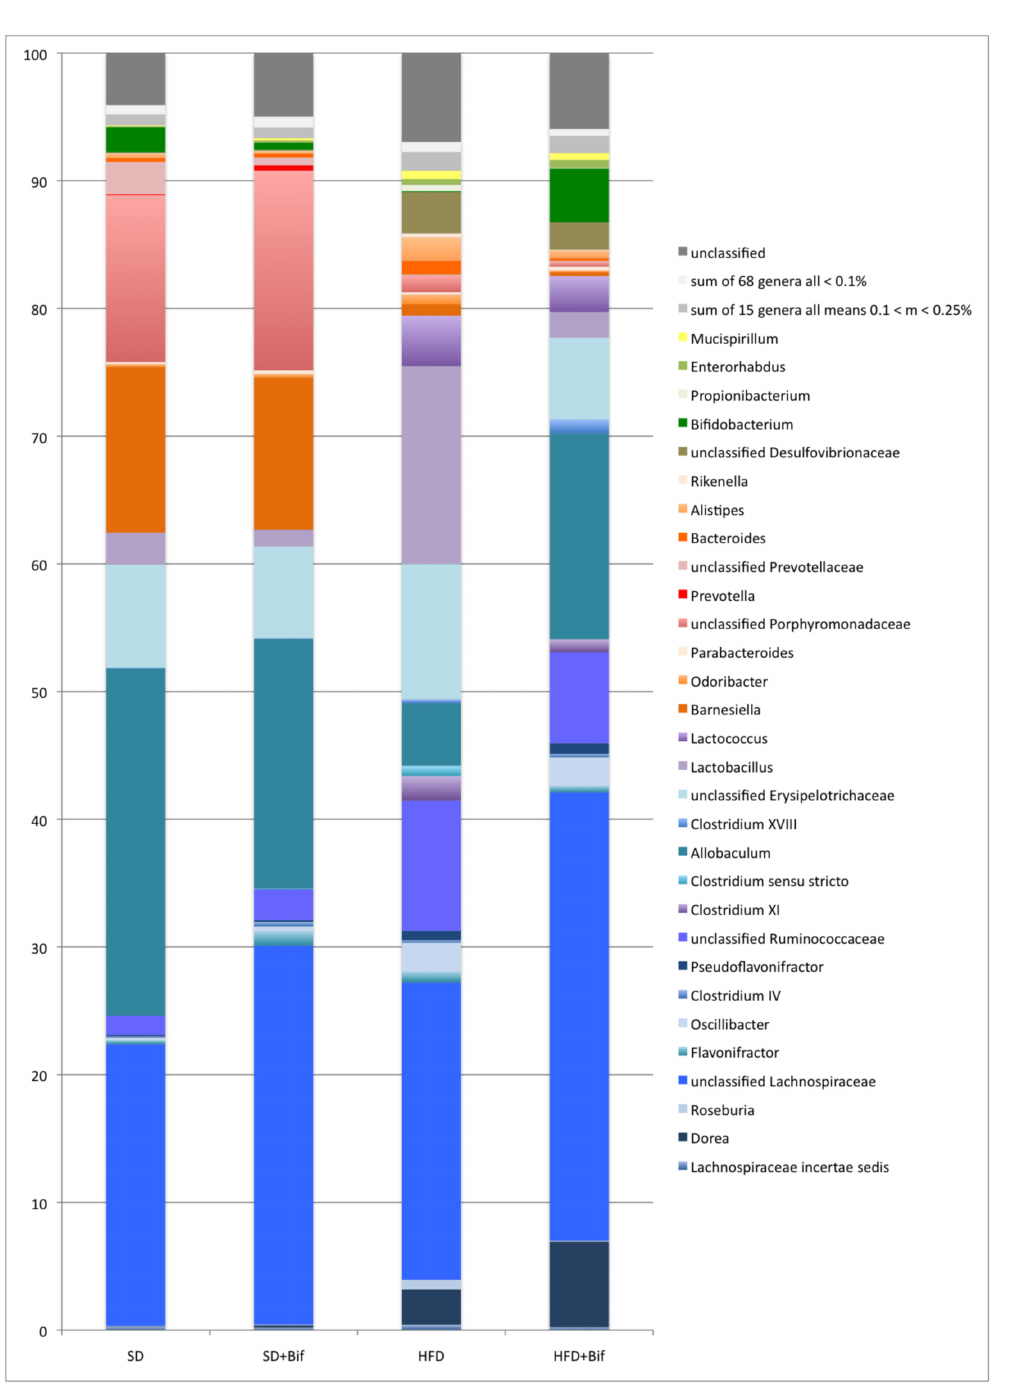
Fig 8. Microbiota composition as determined by pyrosequencing with the RDP multiclassifier in faeces from different mouse groups after 14 weeks of dietary intervention. Data are expressed as mean percentage values from each mouse group (n = 8 per group). Phylum affiliation of the genera is indicated by blue tones for Firmicutes, orange-red for Bacteroidetes, brown for Proteobacteria, green for Actinobacteria and yellow for Deferribacteres. Genera with abundances below 0.1% and between 0.1 and 0.25% are grouped. Reads that had confidence values below 80% at family level are shown as